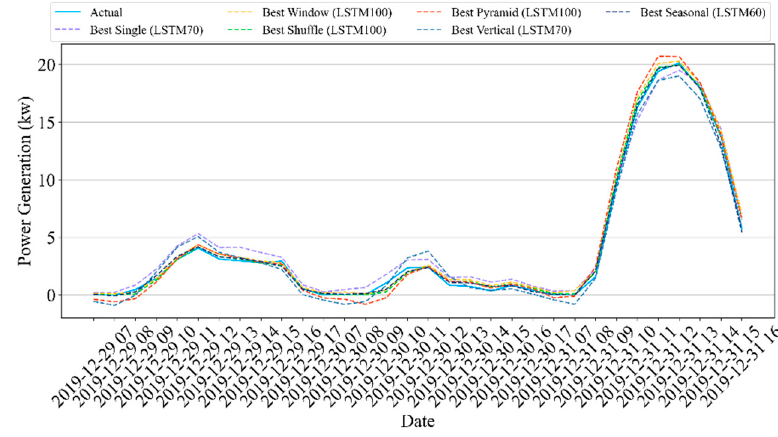
Figure 6. Results of hourly forecasting of Site A. Table 7. Experimental results of daily forecasting of Site A.